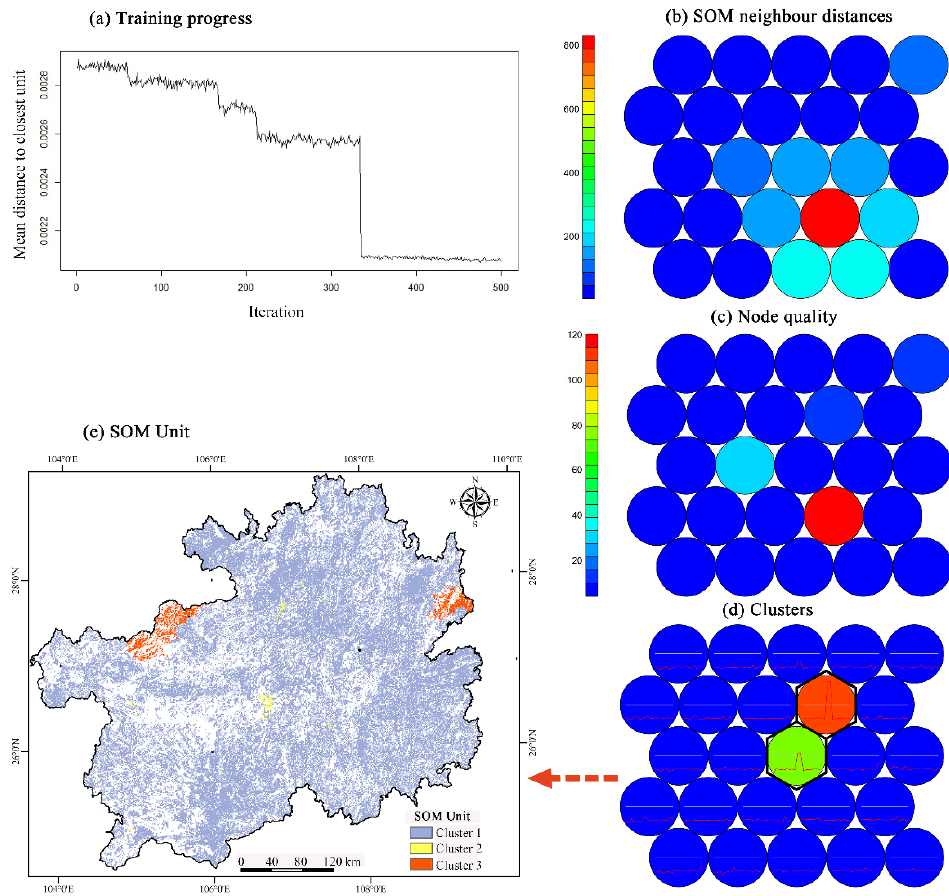
Figure 4. Self-organizing map of the socio-environmental factors.